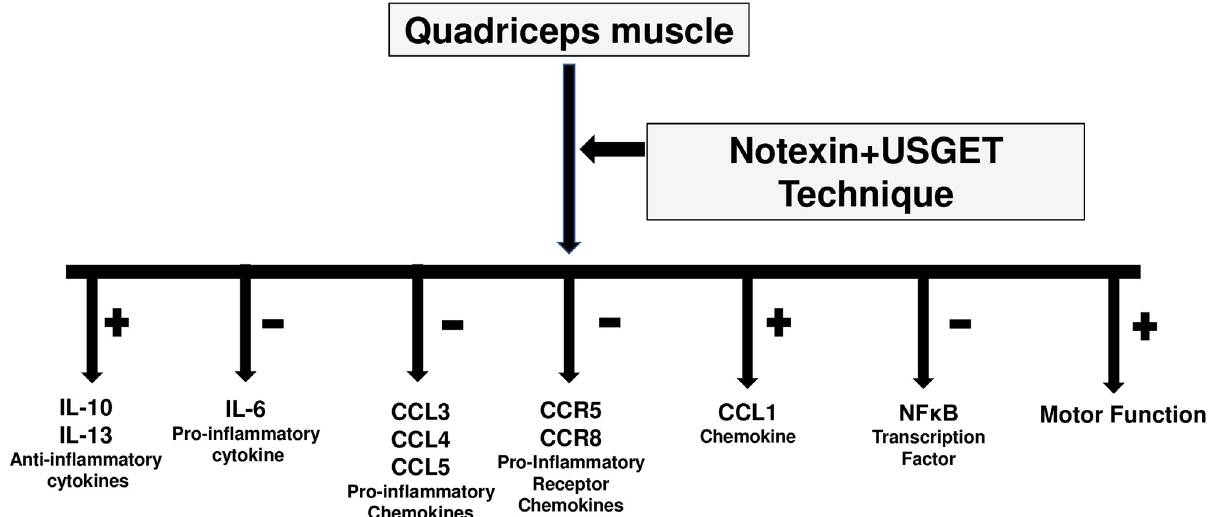
Fig 8. Notexin + USGTE (6 mA) technique action on quadriceps muscle of rat. Increase in anti-cytokines, CCL1 chemokine and motor function with decrease in proinflammatory cytokines, chemokines, chemokines receptors and NF κ B protein are